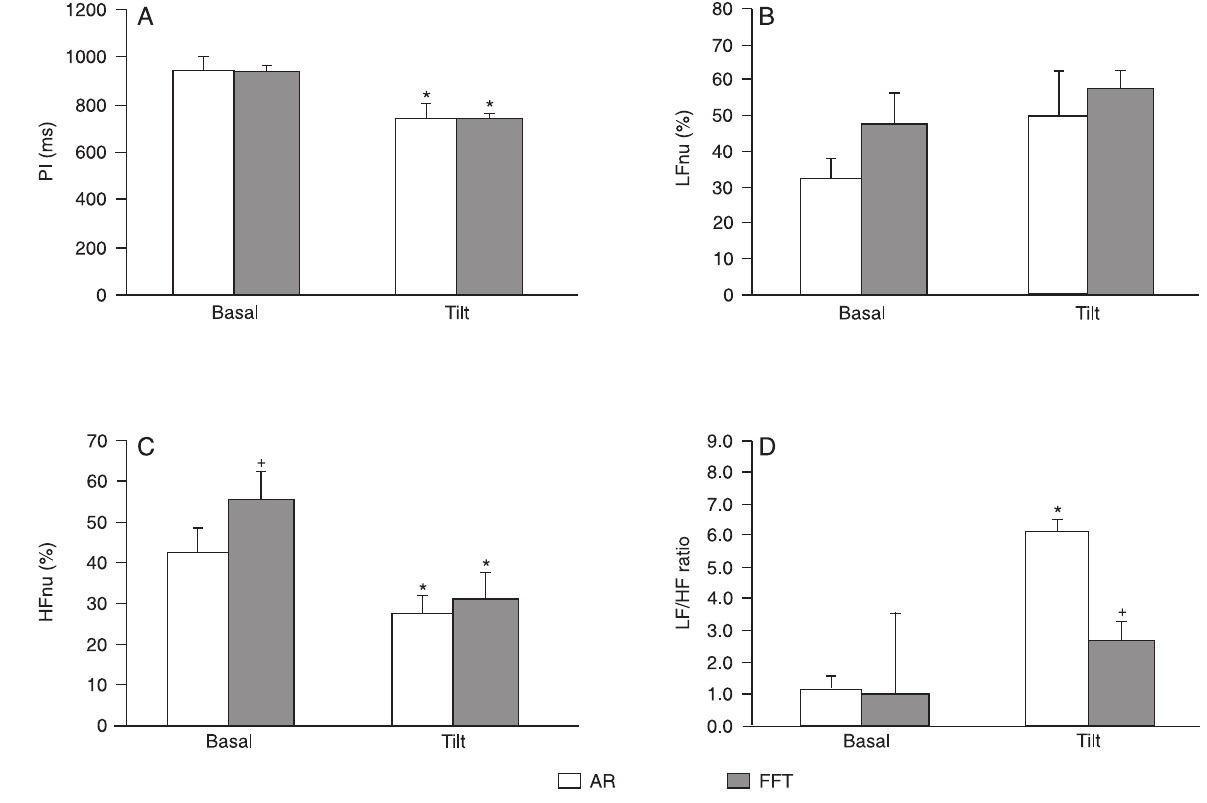
Figure 1. Mean pulse interval (PI, Panel A) and LFnu (Panel B) and HFnu (Panel C) oscillations, and LF/HF ratio (Panel D) for PI at basal condition and after tilt test in normal volunteers. LF = low-frequency; HF = high-frequency; LFnu = normalized power of LF; HFnu = normalized power of HF; AR = autoregressive method; FFT = fast Fourier transform method. *P ≤ 0.05, compared to respective basal group. + P ≤ 0.05, FFT compared to